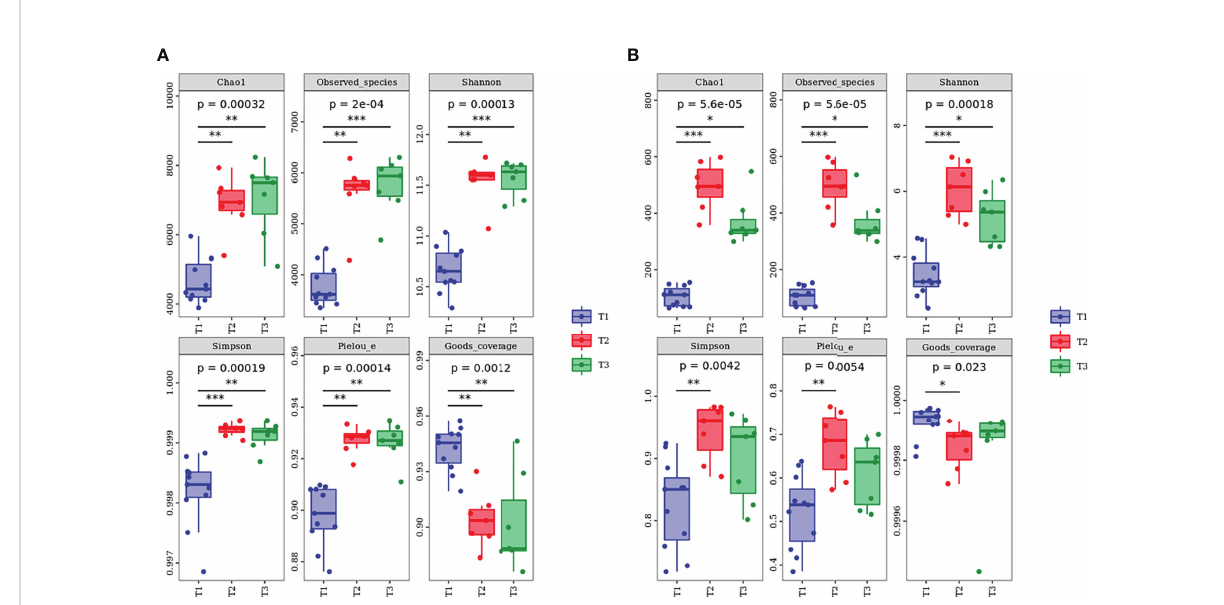
FIGURE 7 Alpha diversity index of (A) bacterial and (B) fungal communities at different water-repellency classes beneath the Pinus (T 1 ), Robinia (T 2 ), and Hippophae (T 3 ). * indicates p <0.05, ** indicates p <0.01, *** indicates p<